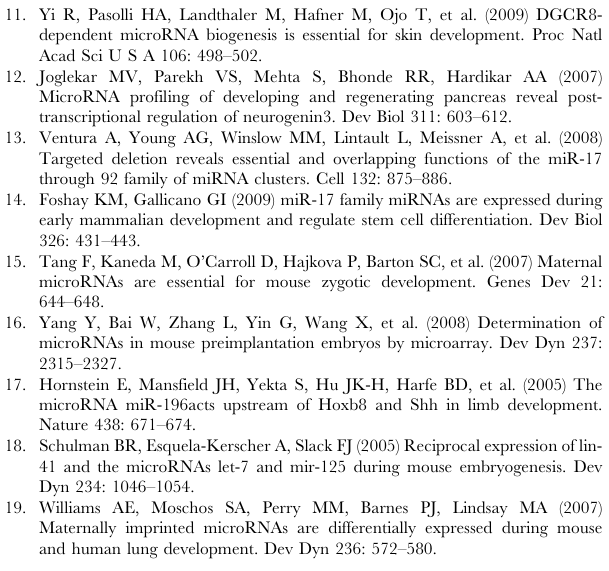
Table S4 Comparative marker selection analysis on zygotes vs. 2-cell embryos. Only SNR . 0.5 or ,2 0.5 are shown.